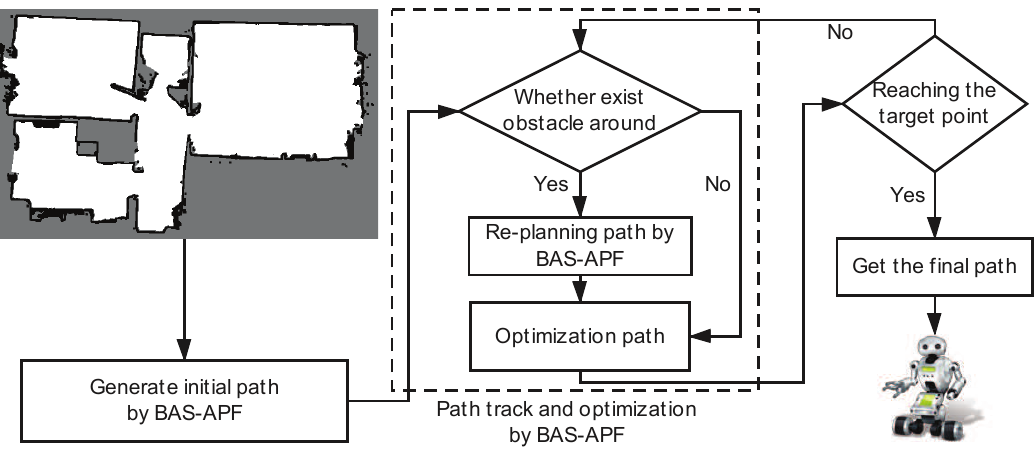
Figure 1. The schematic diagram of the proposed beetle antennae search (BAS)-artificial potential field (APF) method applied to mobile robot path planning in both static and dynamic